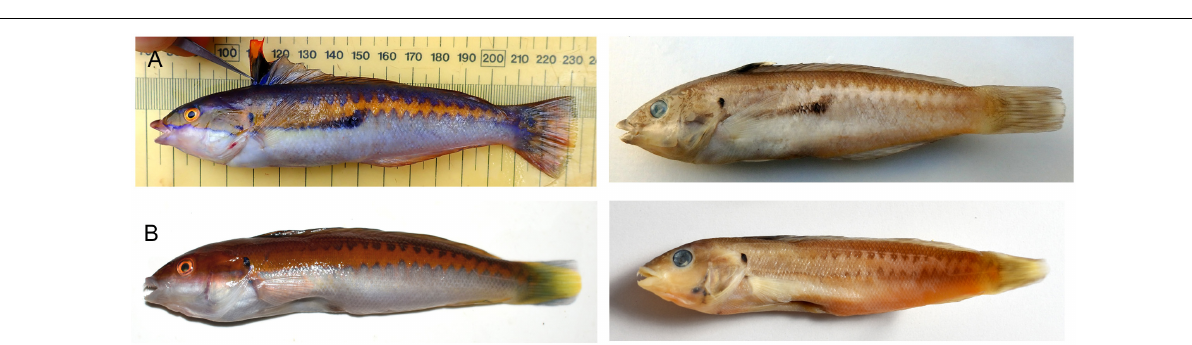
FIGURE 5 | Photographs of fresh and preserved specimens of Coris julis . (A) neotype of Labrus julis Linnaeus, 1758, Labrus cettii Rafinesque, 1810, Labrus giofredi Risso, 1810 and Julis speciosa Risso, 1827 CFM-IEOMA 7433 from Eastern Mallorca, Balearic Islands, Mediterranean Sea, showing the typical coloration of the secondary livery (male); (B) paratype CFM-IEOMA 7432 from Punta Tomàs, Mallorca, Balearic Islands, Mediterranean Sea, showing an intermediate coloration between primary and secondary liveries without elongation of first dorsal spines. The fresh and preservation in formalin color are disposed in right and left site,